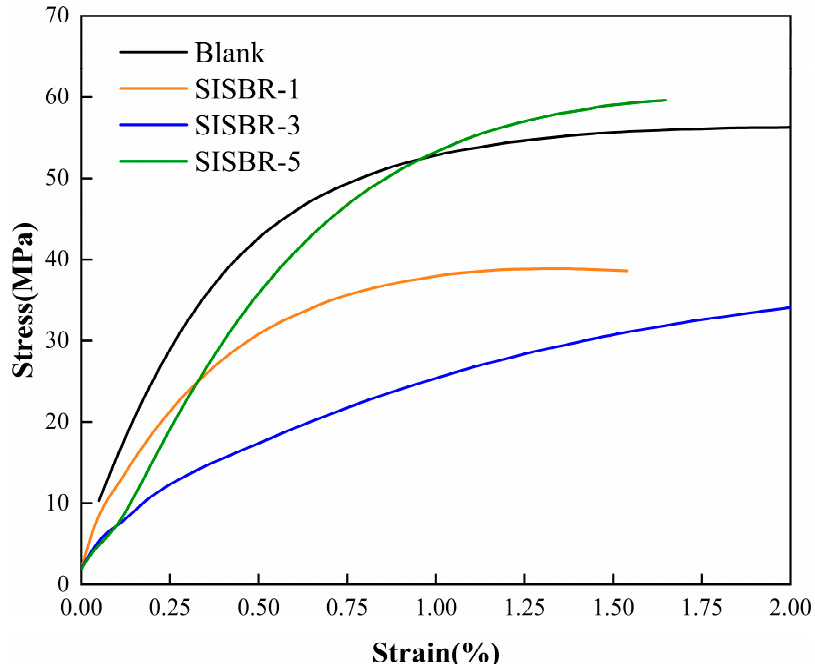
Figure 13. Stress–strain curve of cement paste with SISBR latex powder. Table 2. Comparison of elastic modulus.